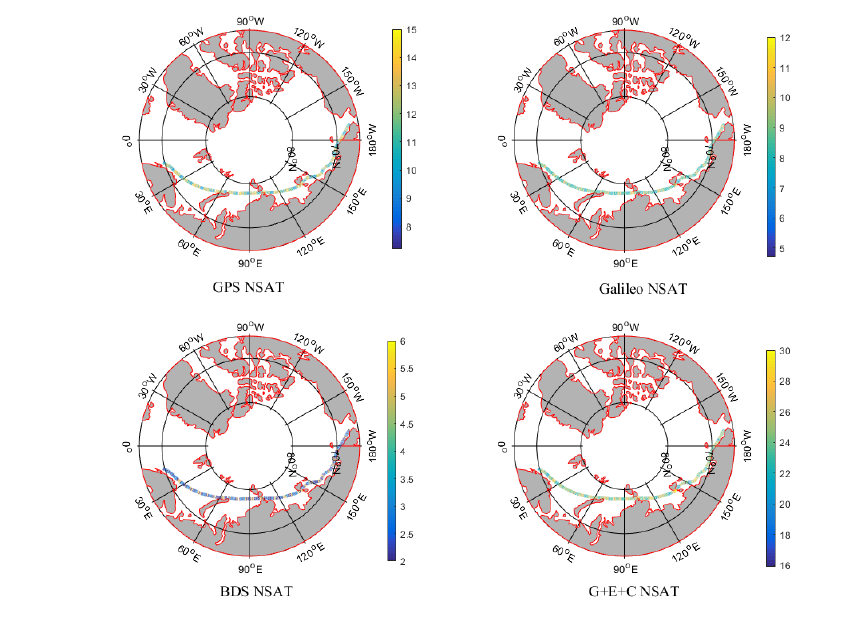
Figure 5. Variation between NSAT for GPS, Galileo, BDS, G+E+C, and the ship position in the NEP.